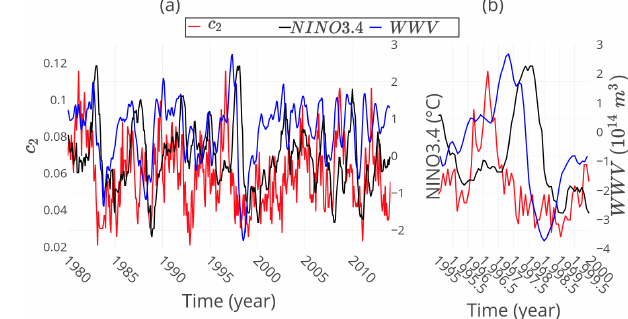
Figure 3. The WWV, c 2 and the NINO3.4 index from observations for (a) the whole considered time series and (b) only during the 1997 El Niño. A warning of the El Niño event is visible for the WWV and c 2 . c 2 gives a warning almost a year before the 1997 El Niño, while the WWV warns almost 7 months ahead.